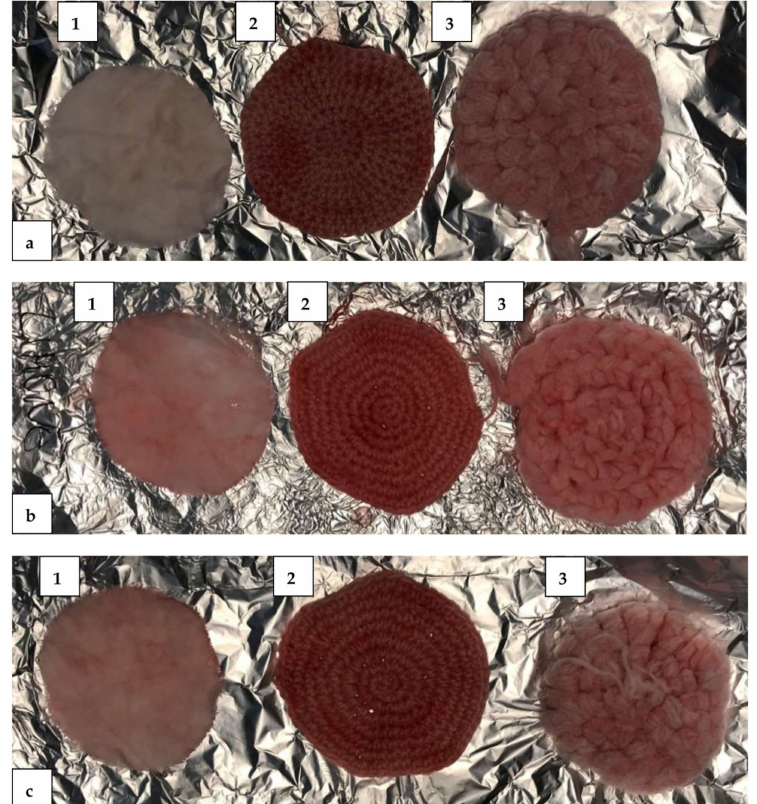
Figure 3. Fiber discs of ( 1 ) linen. ( 2 ) cotton and ( 3 ) wool after treatment with dye solutions: ( a ) colored with dye extract without the use of mordants (DWM); ( b ) stained with dye extract with pre-treatment with lemon juice (DPL); ( c ) stained with dye extract with pre-treatment with aluminum potassium sulphate